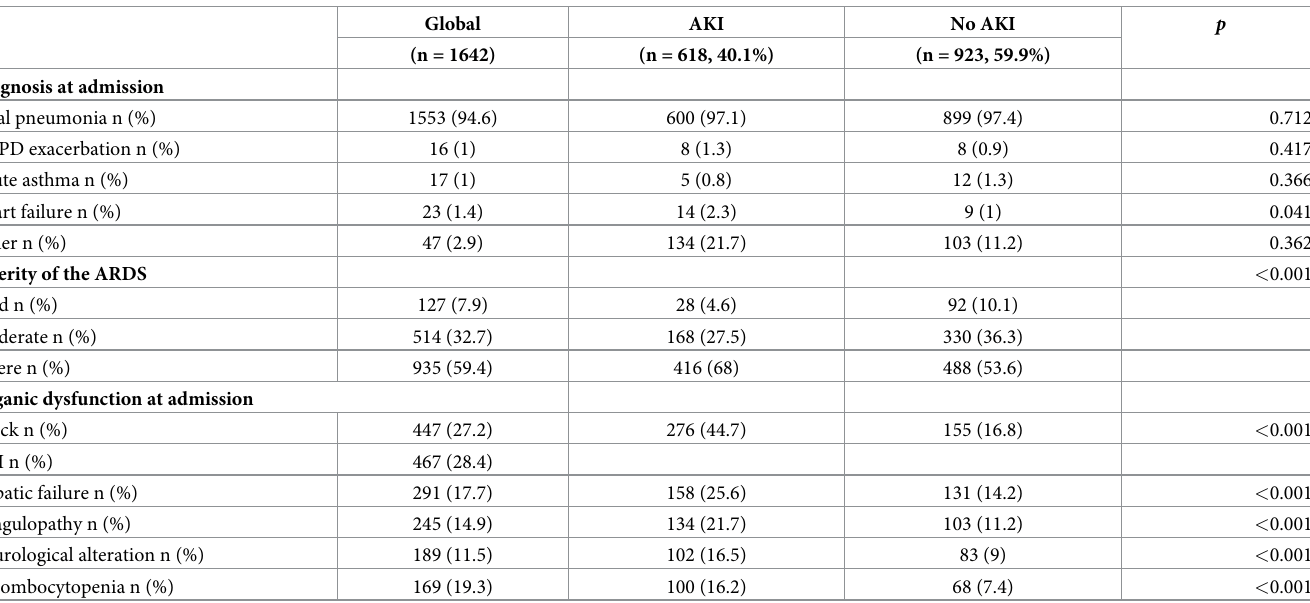
Table 2. ICU admission and organic